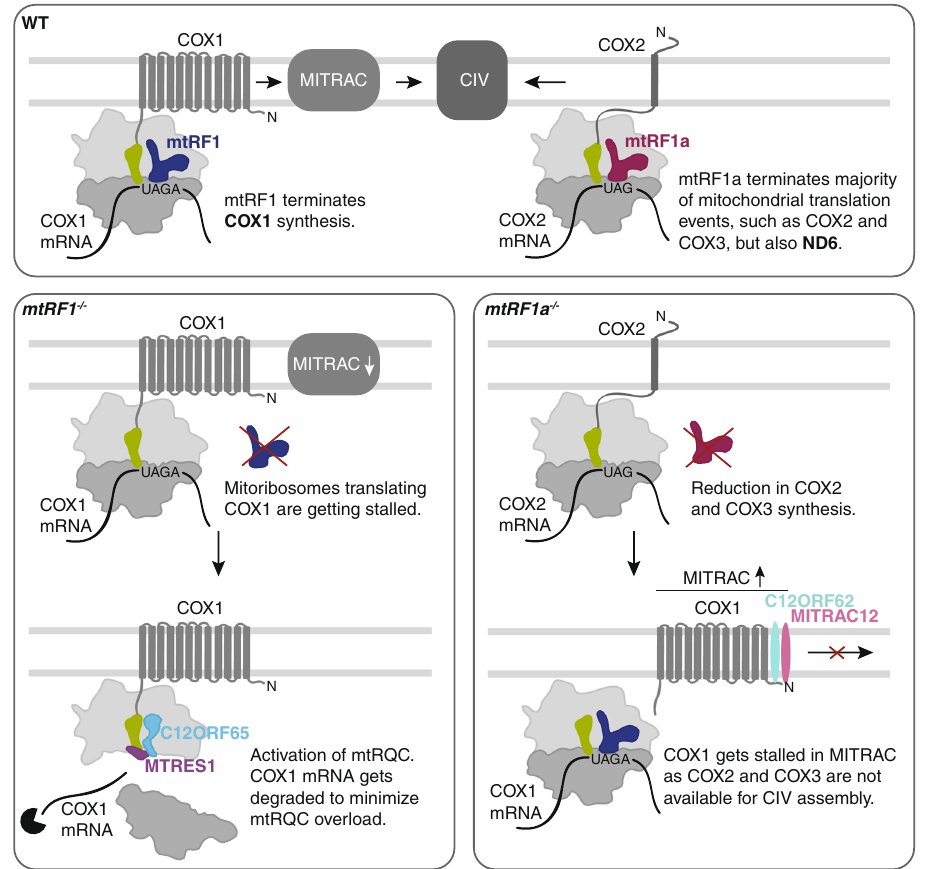
Fig.6|TheroleofmtRF1andmtRF1aduringtranslationterminationinhuman mitochondria. mtRF1 (blue) speci fi cally terminates COX1, whose synthesis and subsequent assembly is coordinated by MITRAC. In contrast mtRF1a (red) facil- itates the release of COX2 and other mtDNA-encoded proteins including ND6. In the absence of mtRF1, termination of COX1 translation is affected and ribosomes aregettingstalled.ThedecreaseofnewlysynthesizedCOX1leadstoareductionof MITRAC in mtRF1 − / − . Stalled COX1-translating ribosomes are rescued by the